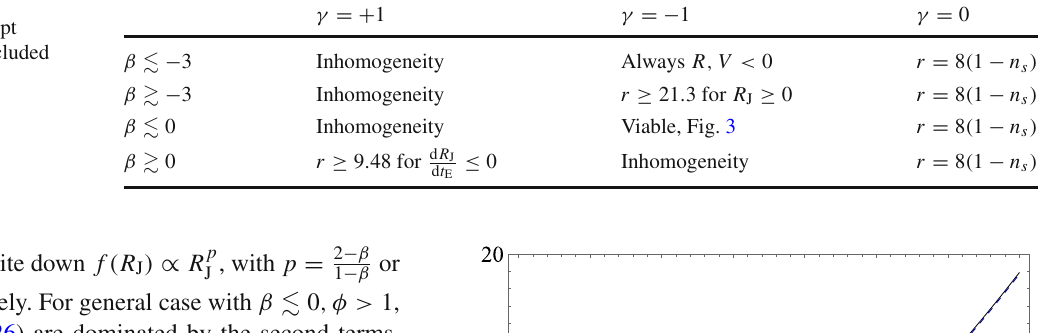
Table 1 Reasons why parameter regions except β (cid:2) 0 ,γ = − 1 are excluded